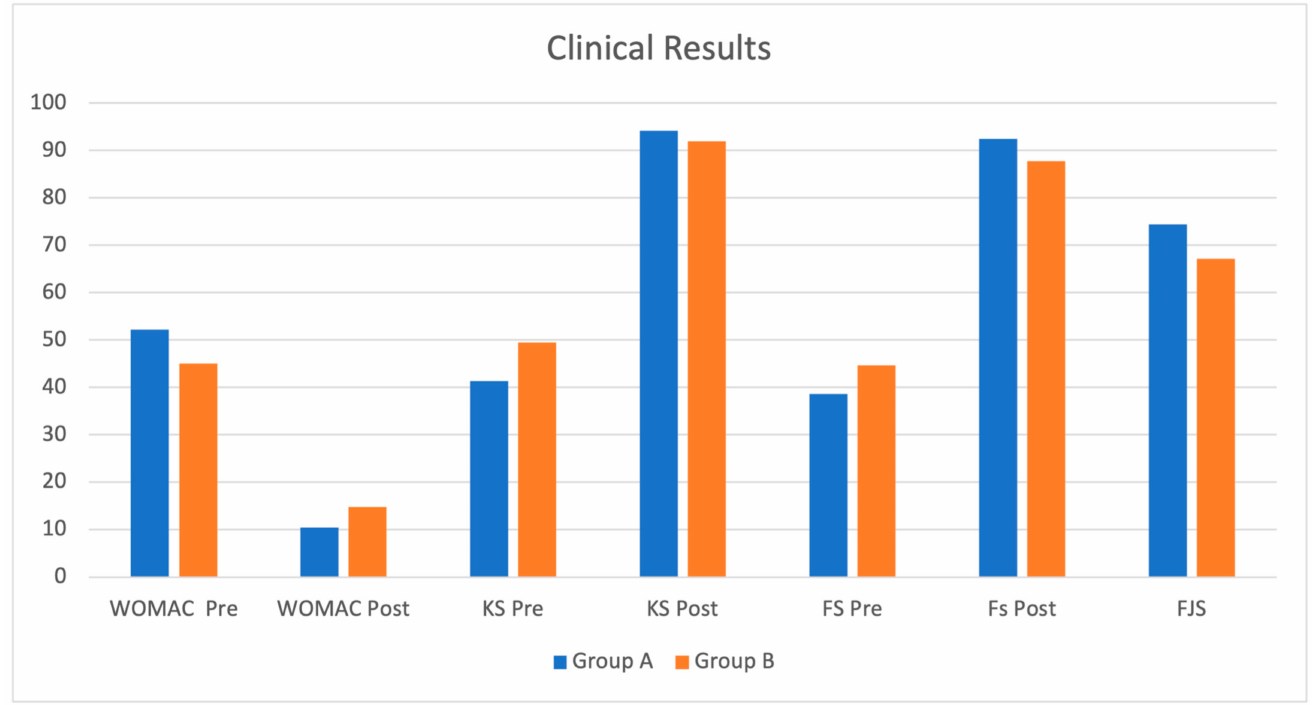
Figure 3. Clinical results for the two study groups. No significant differences in clinical improvement